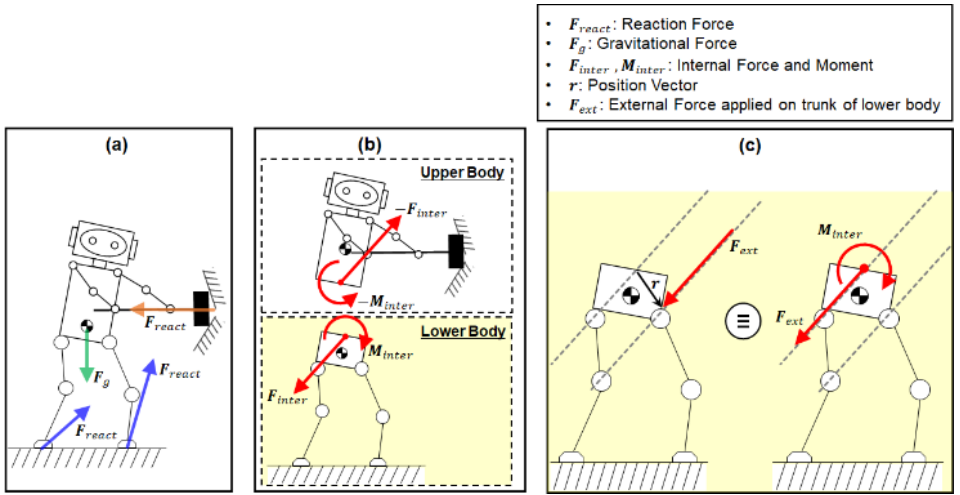
Figure 1. Two parallel-coupled sub-systems of the humanoid: ( a ) Free body diagram of the humanoid interacting with the environment, ( b ) Internal force and moment between the upper and lower bodies, ( c ) External force having the same effect as the internal force and moment.